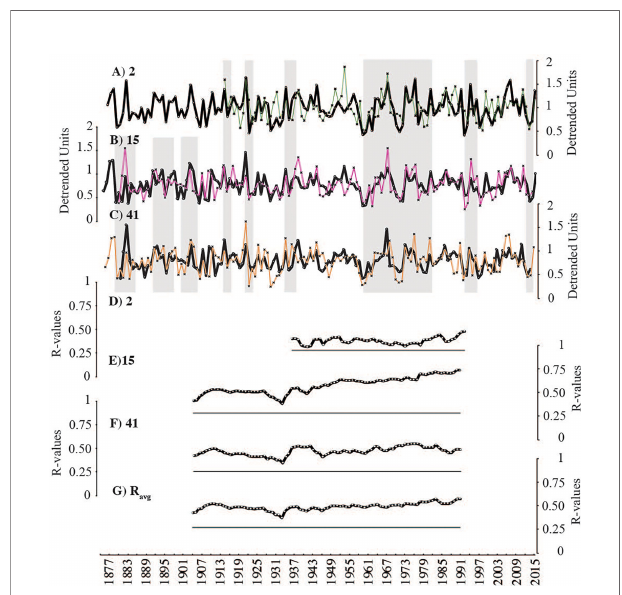
FIGURE 4 | Growth anomalies of non-crossdated annual growth increments for all samples. Only sample averages shown here. All yielded signi fi cant intra- sample correlations ( Table 2 ). Timeseries developed with Mg/Ca-visual methods (top panel – red box) and visual methods (lower panel) shown.